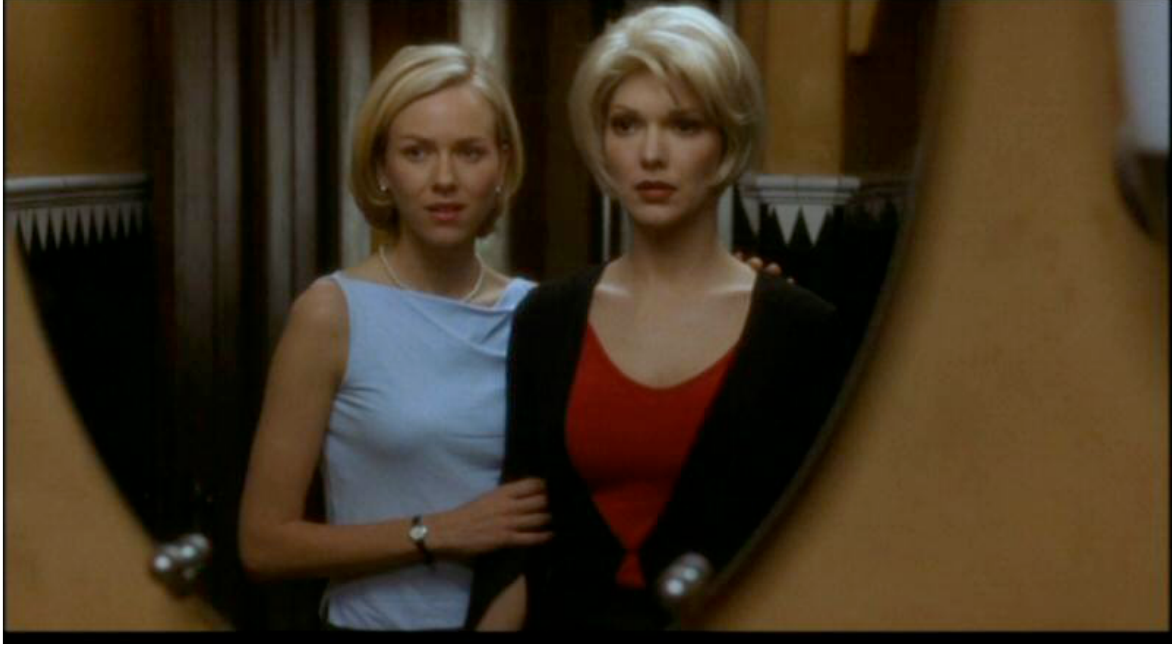
Figure 1: Diane/Betty wants to be successful and in a reverse fantasy she gets to shape success as the other (Camille/Rita) to herself.